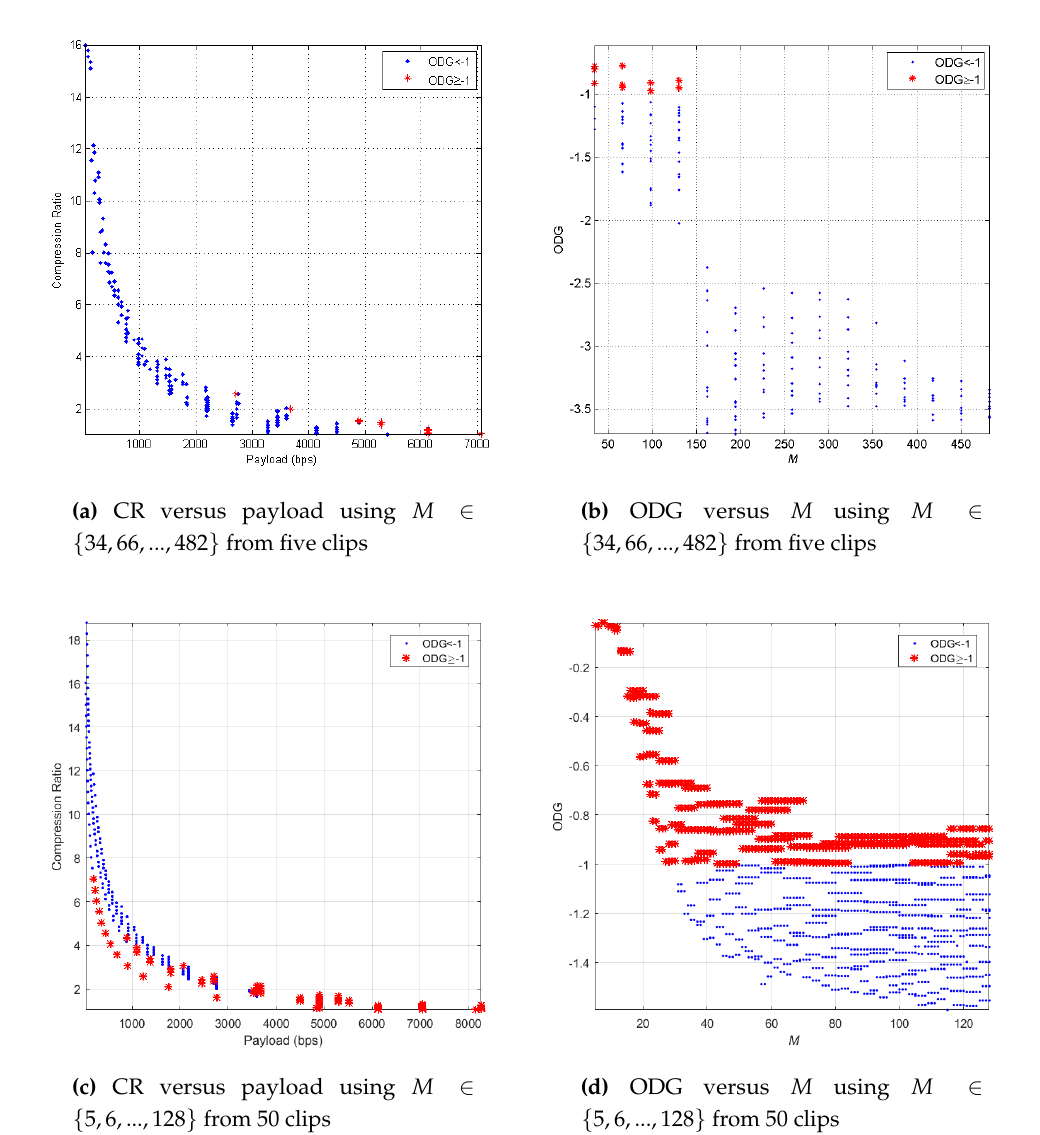
Figure 4. ODG in relation to M , payload, and